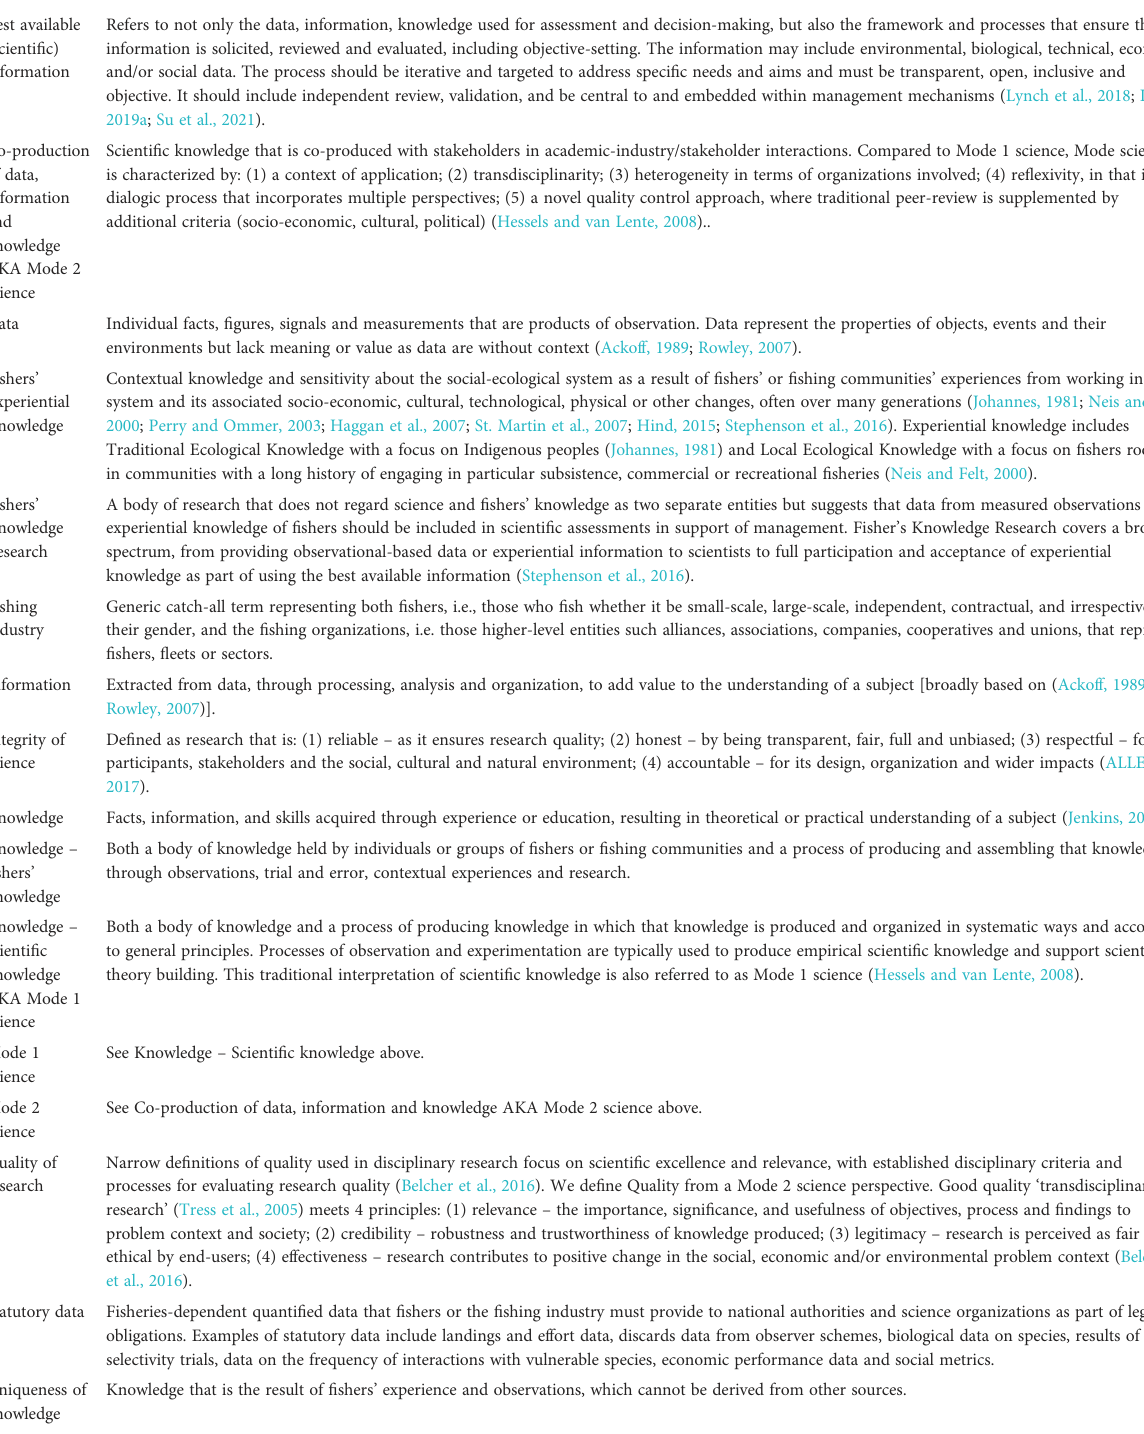
TABLE 1 Operational de fi nitions of terminology (in alphabetical order). Term De fi